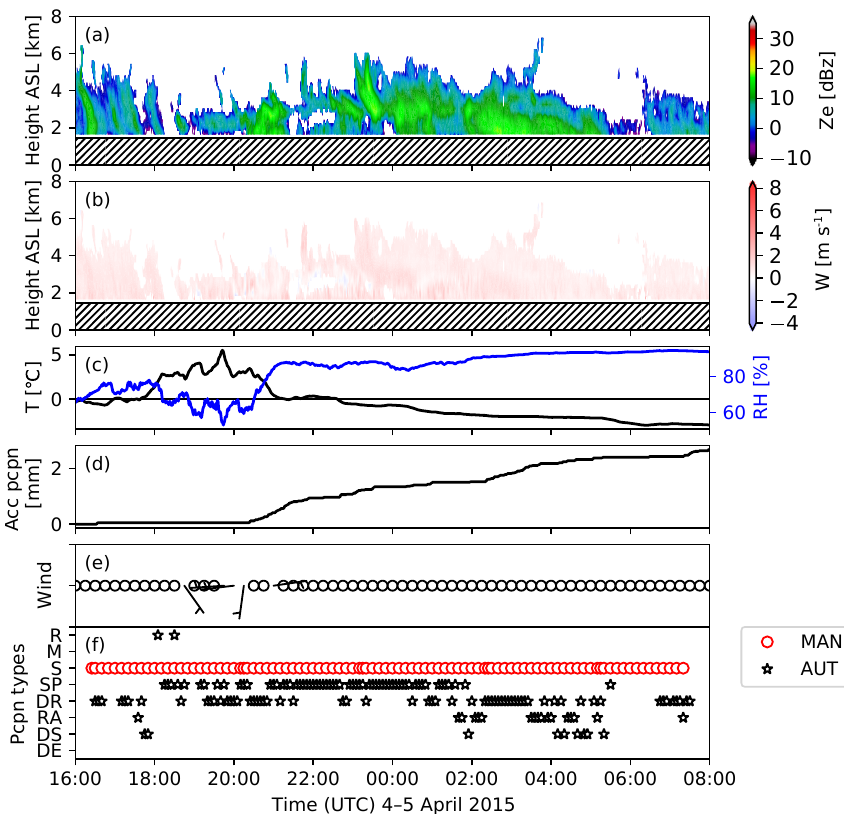
Figure 6. Same as Fig. 5 but for 4–5 April 2015 for the easterly flow field event.